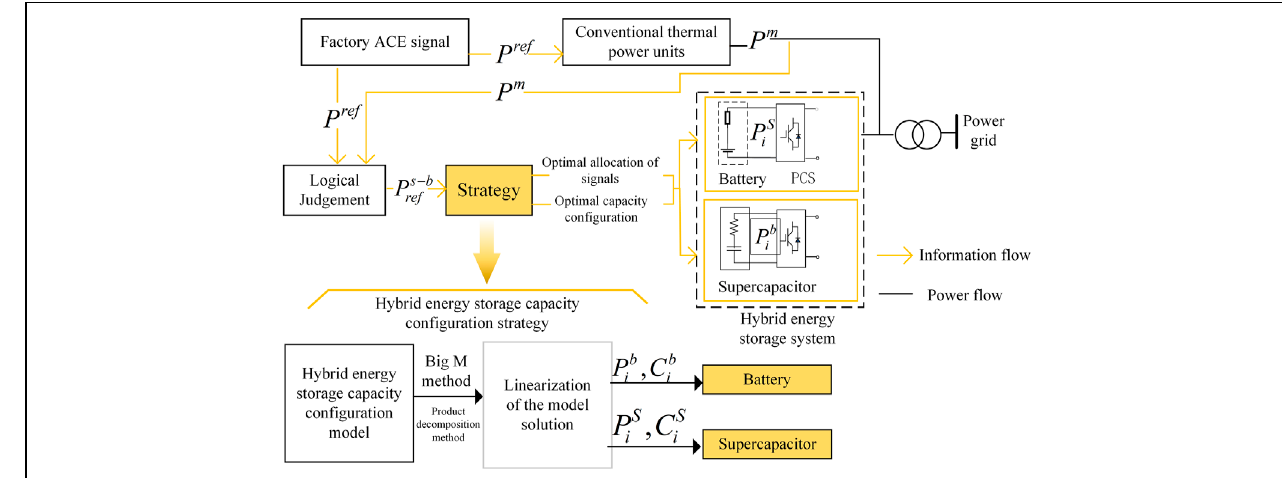
FIGURE 2 | Hybrid energy storage capacity configuration strategy.